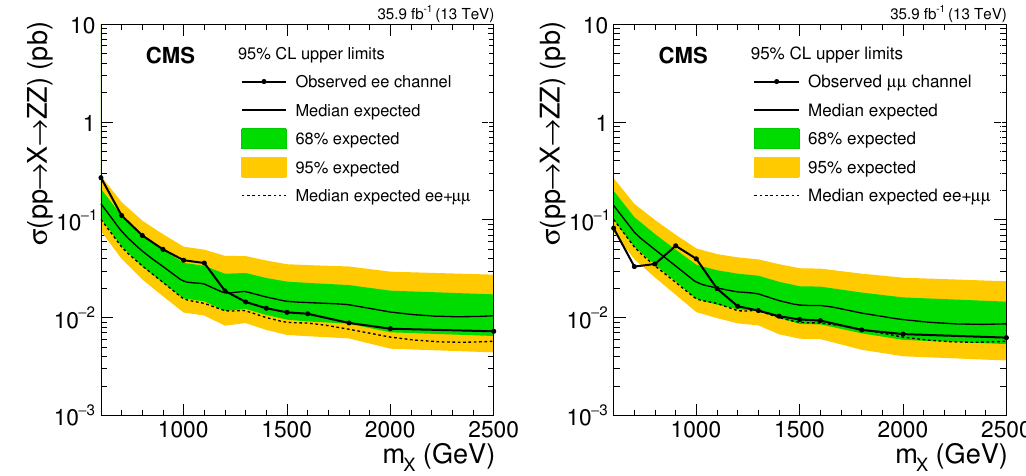
Figure 6 . Expected and observed limits on the product of cross section and branching fraction of a new spin-2 bulk heavy resonance X ! ZZ, assuming zero width, shown separately for searches X ! ZZ ! ‘‘(cid:23)(cid:23) in the electron (left) and muon (right) (cid:12)nal states. The median expected 95% CL limits from the combined analysis ((cid:12)gure 5) are also shown.